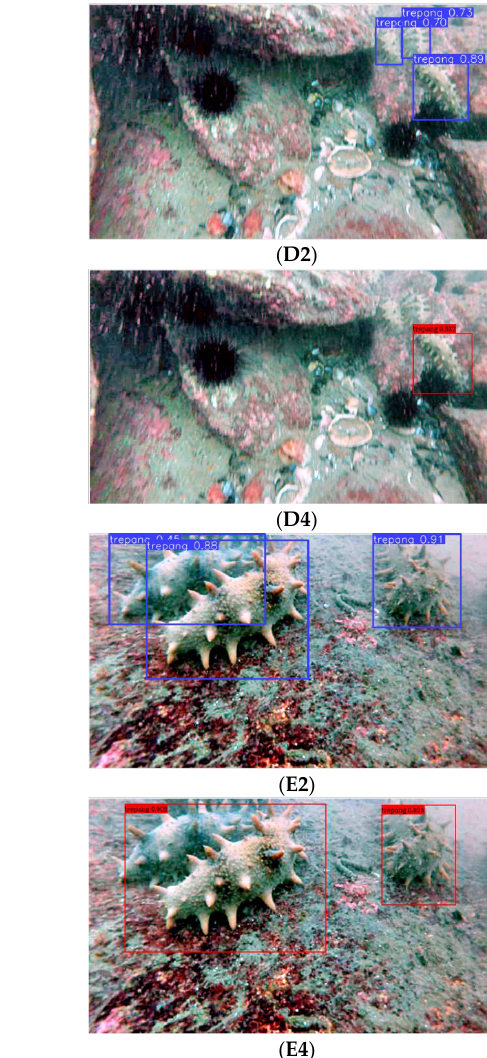
Figure 12. Images detection using improved YOLOv5s, YOLOv5s, YOLOv4, and Faster-RCNN. Image ( A1 , B1 , C1 , D1 , E1 ) are the results of YOLOv5s; Image ( A2 , B2 , C2 , D2 , E2 ) are the results of improved YOLOv5s; Image ( A3 , B3 , C3 , D3 , E3 ) are the results of YOLOv4; ( A4 , B4 , C4 , D4 , E4 ) are the results of Faster-RCNN.